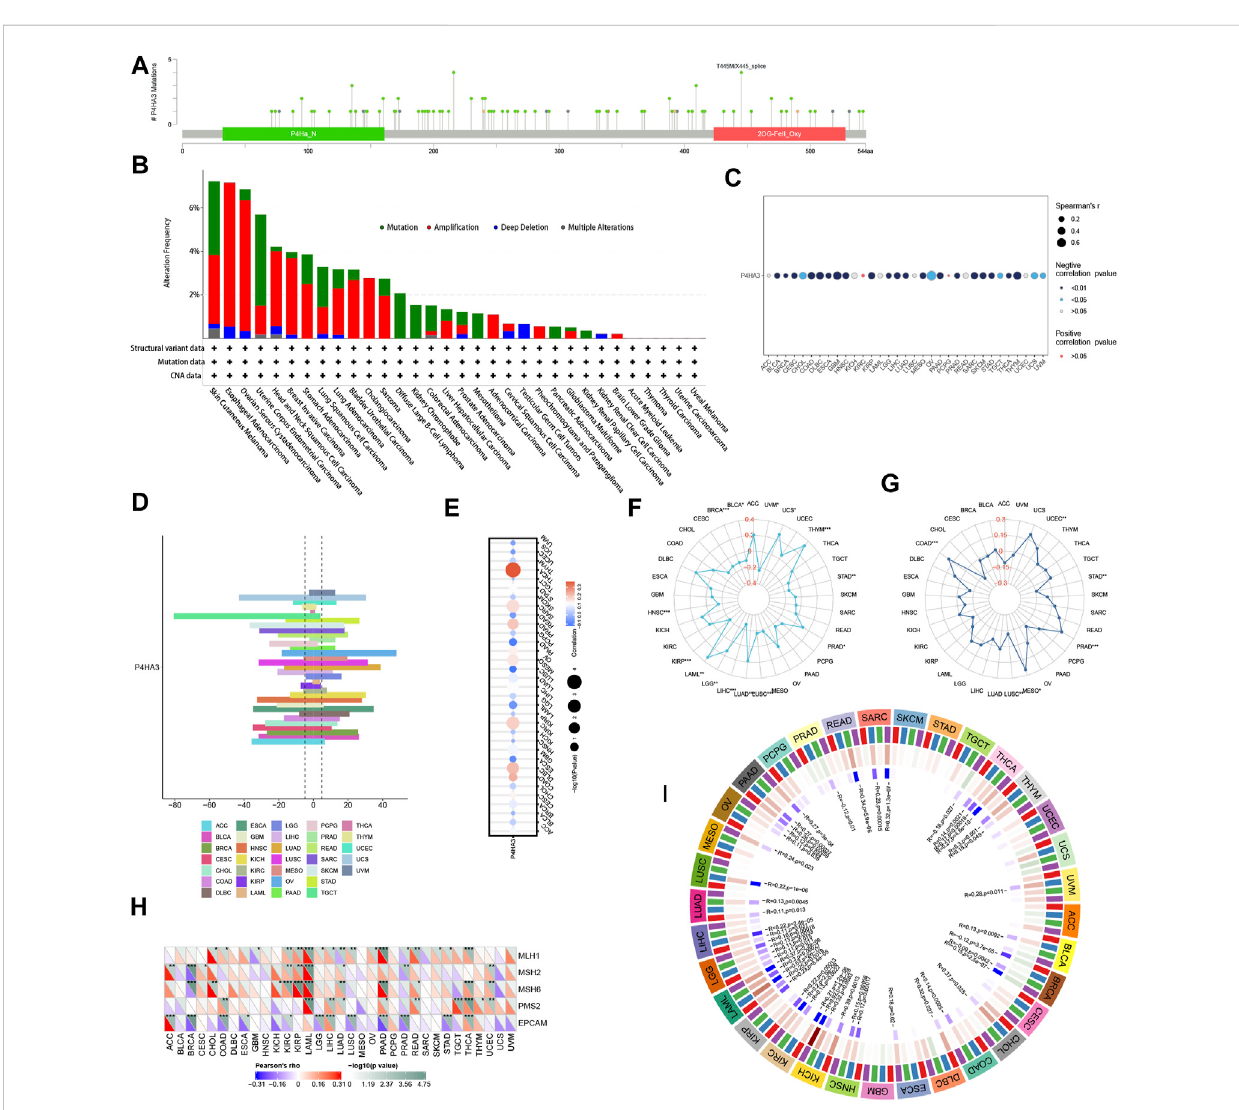
FIGURE 9 (A) Mutationsitesof P4HA3 and (B) Themutationfrequencyandcorrespondingmutationtypesof P4HA3 indifferentcancers. (C) TheRelationshipof P4HA3 expression with methylation. (D) CNV expression of P4HA3 in human pan-cancer. (E) Correlation analysis of P4HA3 CNV expression with P4HA3 mRNA expression. The Relationship of P4HA3 expression with (F) TMB and (G) MSI. Figure 10: Correlation analysis of P4HA3 expression with (H)